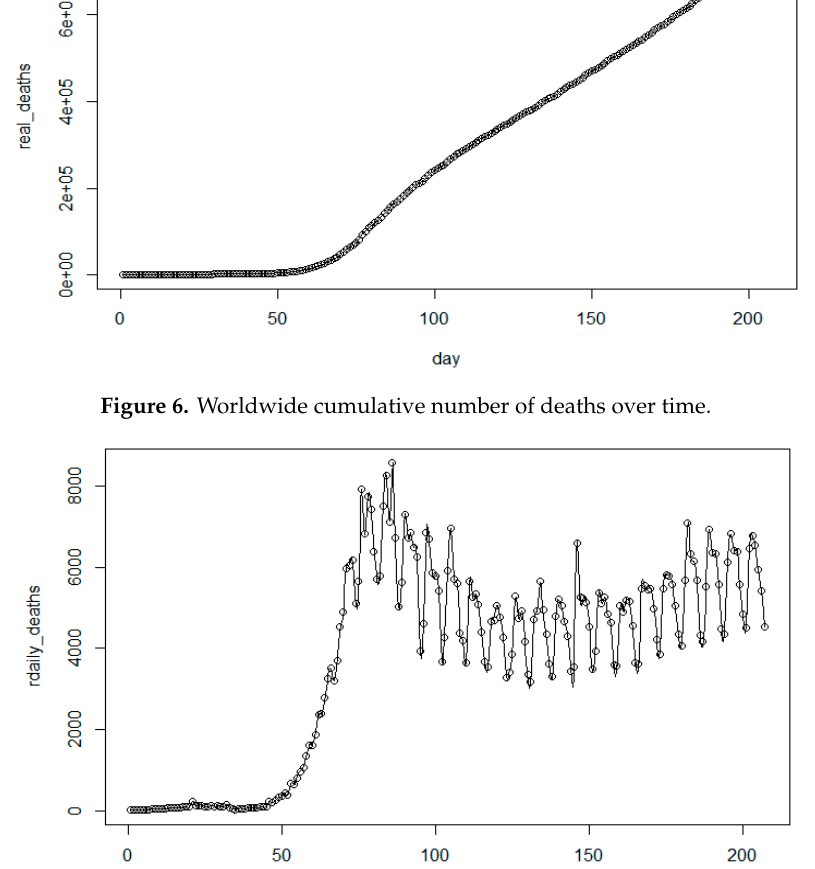
Figure 7. Worldwide daily number of deaths over time.